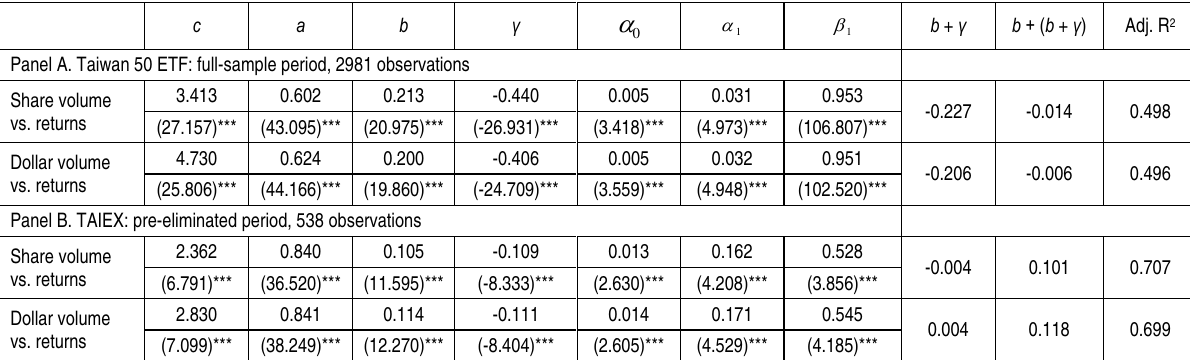
Table 4. GARCH (1,1) estimates of volume-signed return